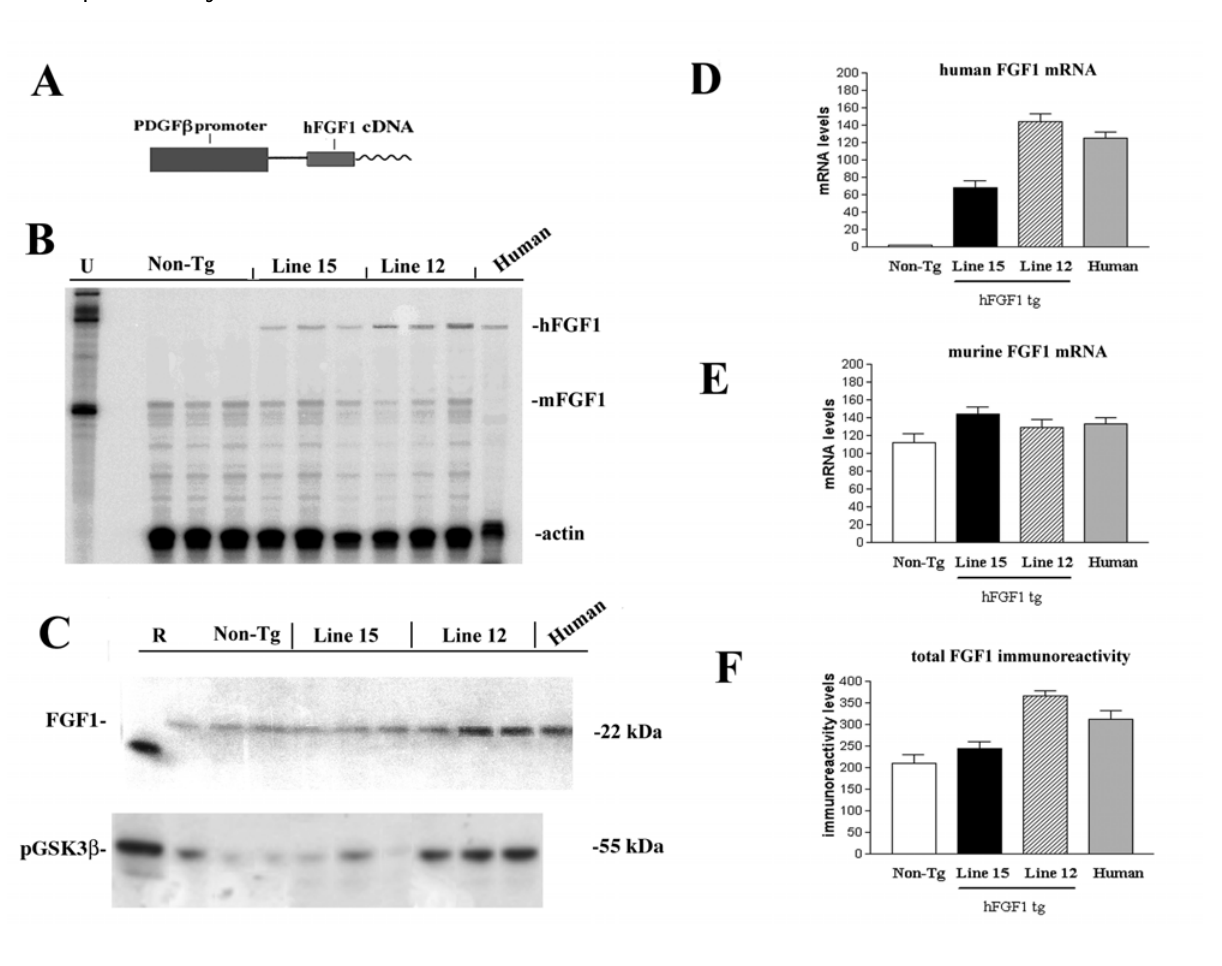
Figure 2. Characterization of hFGF1 tg mice. (a) Construct expressing hFGF1 under the control of the PDGF  promoter. (b) RPA analysis of FGF1 mRNA expression. (c) Immunoblot analysis of total FGF1 protein expression and inactivation of GSK3  in FGF1 tg mice. (d) Semi-quantitative analysis of hFGF1 mRNA levels. (e) Semi-quantitative analysis of mFGF1 mRNA levels. (e) Semi-quantitative analysis of total FGF1 protein expression by